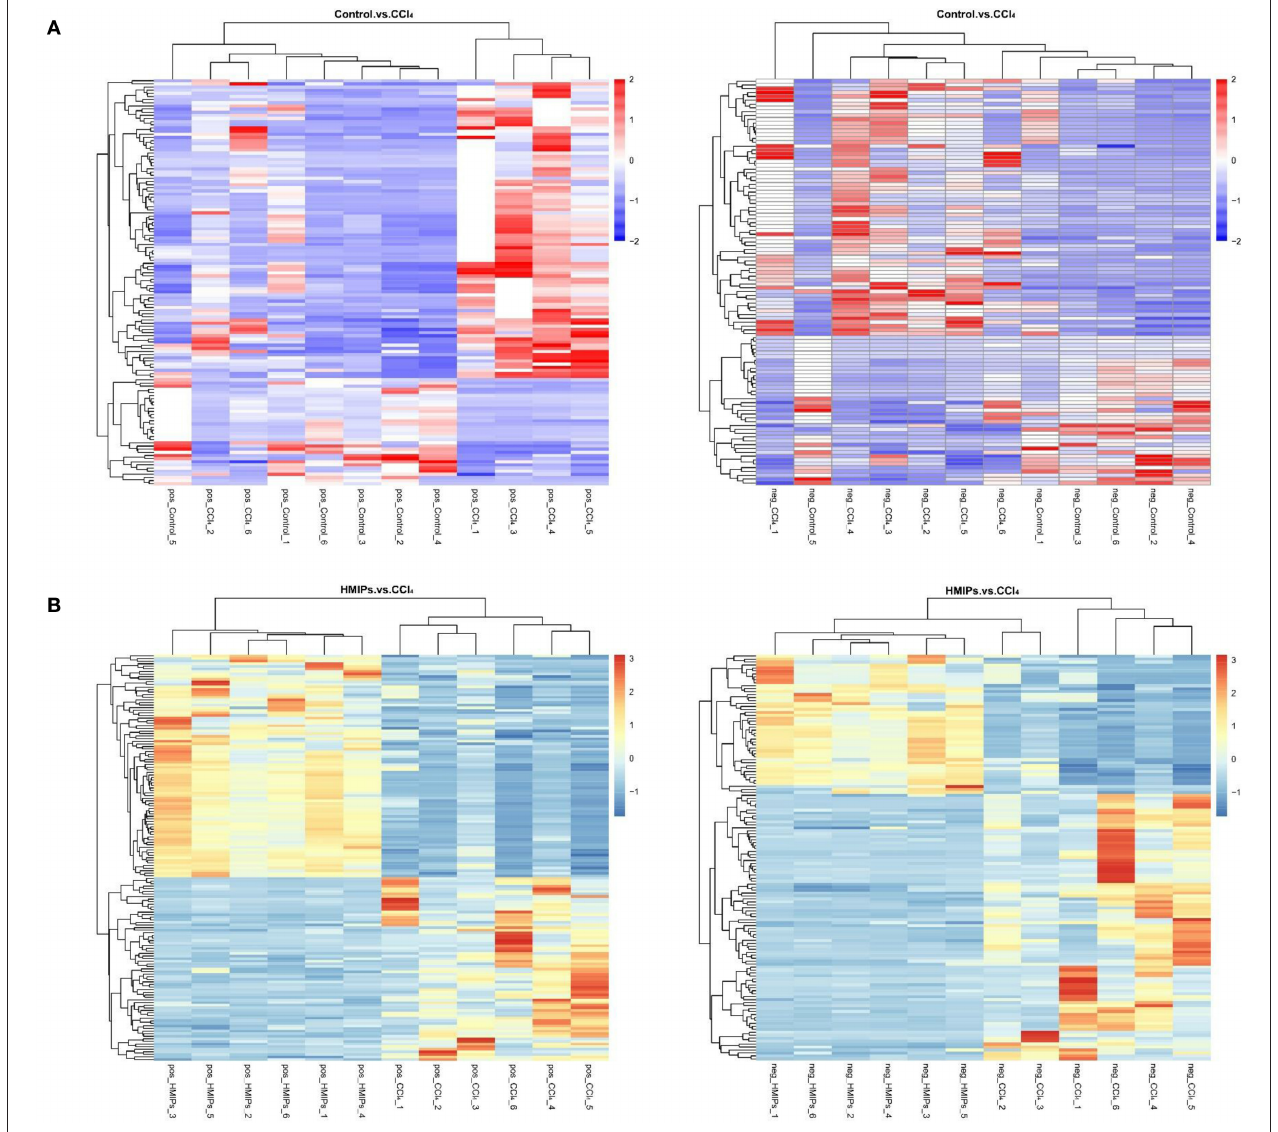
FIGURE 10 | Heat map of hierarchical clustering analysis (HCA) for differential metabolites. (A) Heat map of the control and CCl 4 groups under the positive and negative ion models. (B) Heat map of the HMIP and CCl 4 groups under the positive and negative ion models. Colors represent signal intensities from 0% (blue) to 100%